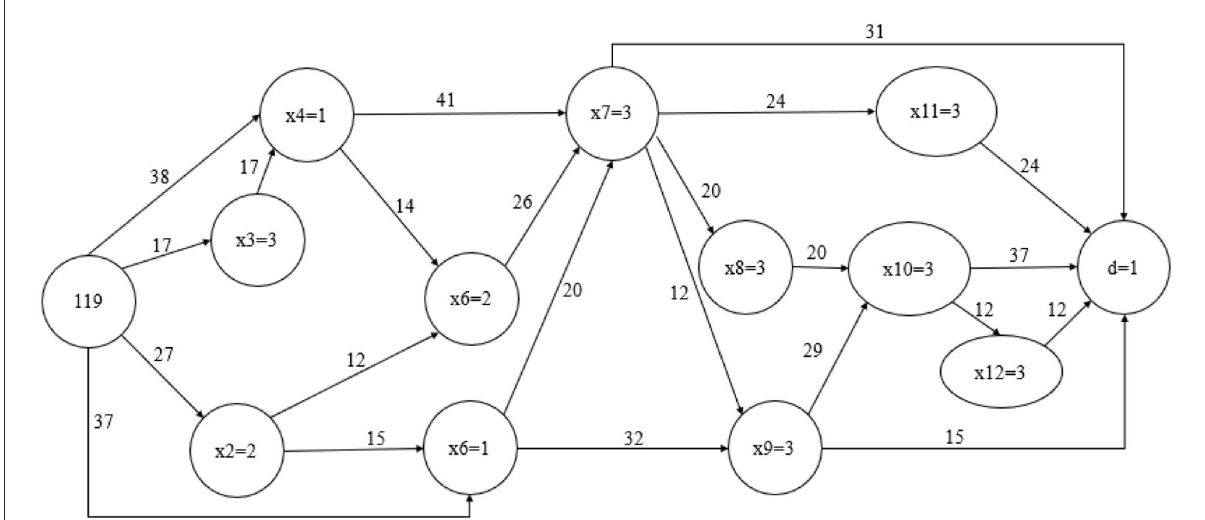
FIGURE2 Decision flow graph and rule-set of low intention to use GMFs class. x2 = 2 means that consumer’s age is from 30 to 39; x3 = 3 means that consumer has master degree; x4 = 1 means that consumer is student; x6 = 1 means that consumer’s perception of CSR is low; x6 = 2 means that consumer’s perception of CSR is medium; x7 = 3 means that consumer’s concerns about GMFs is high; x8 = 3 means that consumer’s promotion focus toward GMFs is high; x9 = 3 means that consumer’s prevention focus toward GMFs is high; x10 = 3 means that consumer’s autonomy to choose GMFs is high; x11 = 3 means that consumer’s competence to choose GMFs is high; x12 = 3 means that consumer’s relatedness to choose GMFs is high; d = 1 means that consumer’s intention to use GMFs is low.